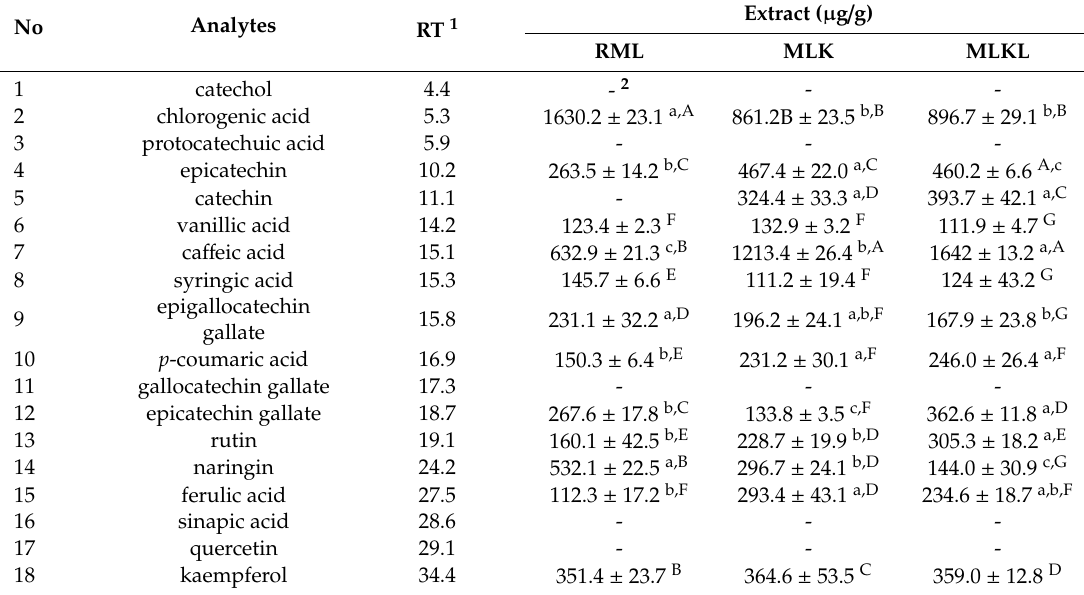
Table 2. Changes in phenolic concentration in mustard